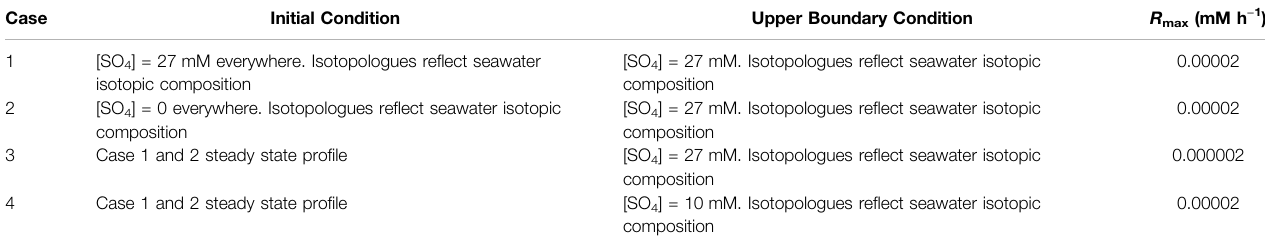
TABLE 2 | A list of test cases and their boundary conditions. All cases have the same lower boundary condition of a concentration gradient of zero for all species. Case Initial